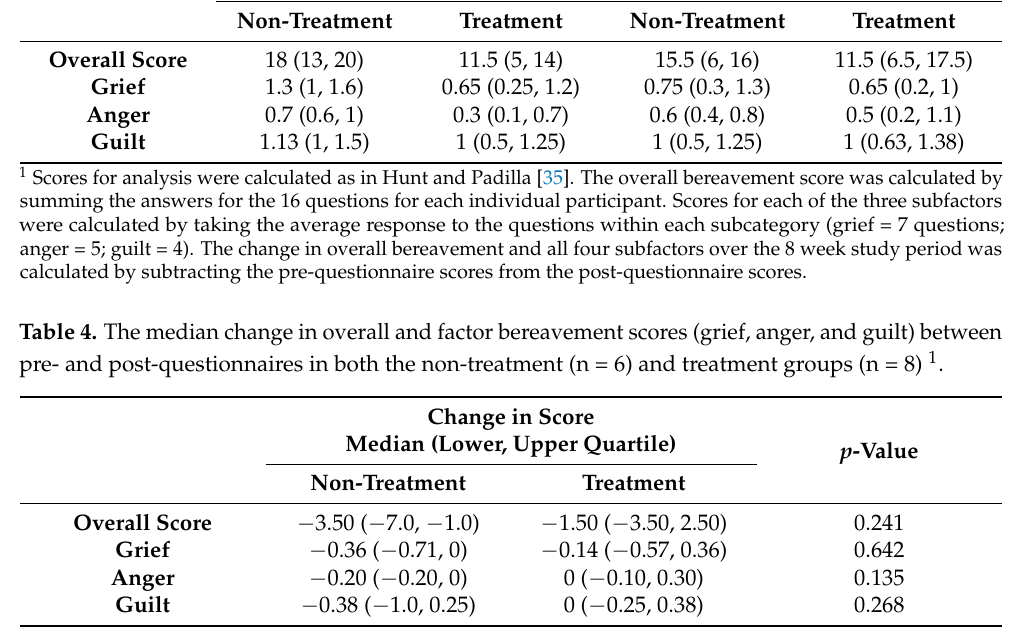
1 Scores for analysis were calculated as in Hunt and Padilla [35]. The overall bereavement score was calculated by summing the answers for the 16 questions for each individual participant. Scores for each of the three